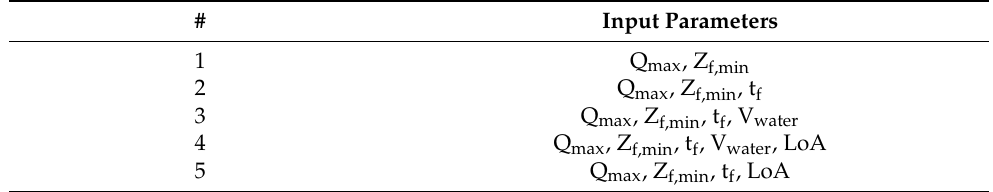
Table 4. Different combinations of input parameters (IPs).